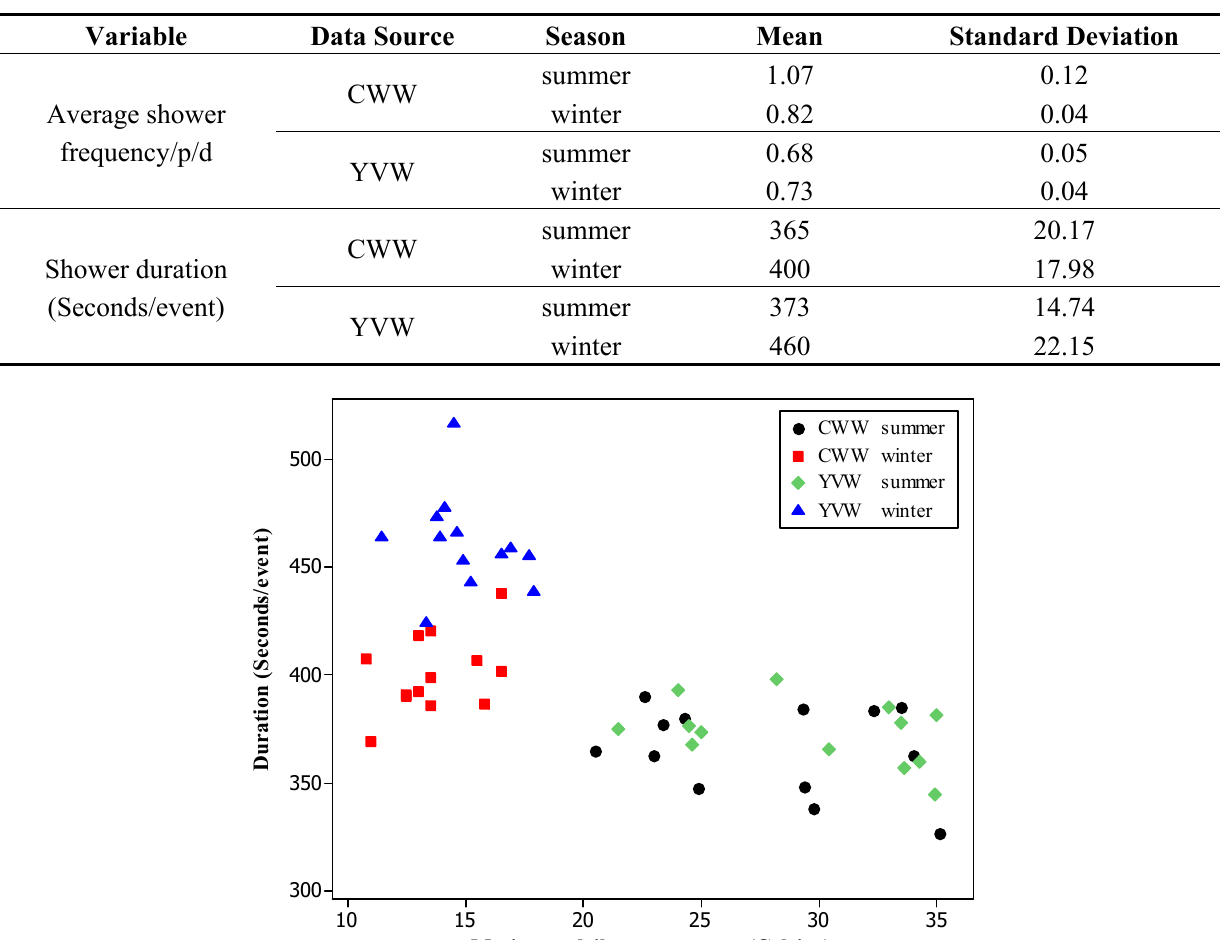
Table 6. Average shower frequency and shower duration in two seasons in CWW and YVW data samples.